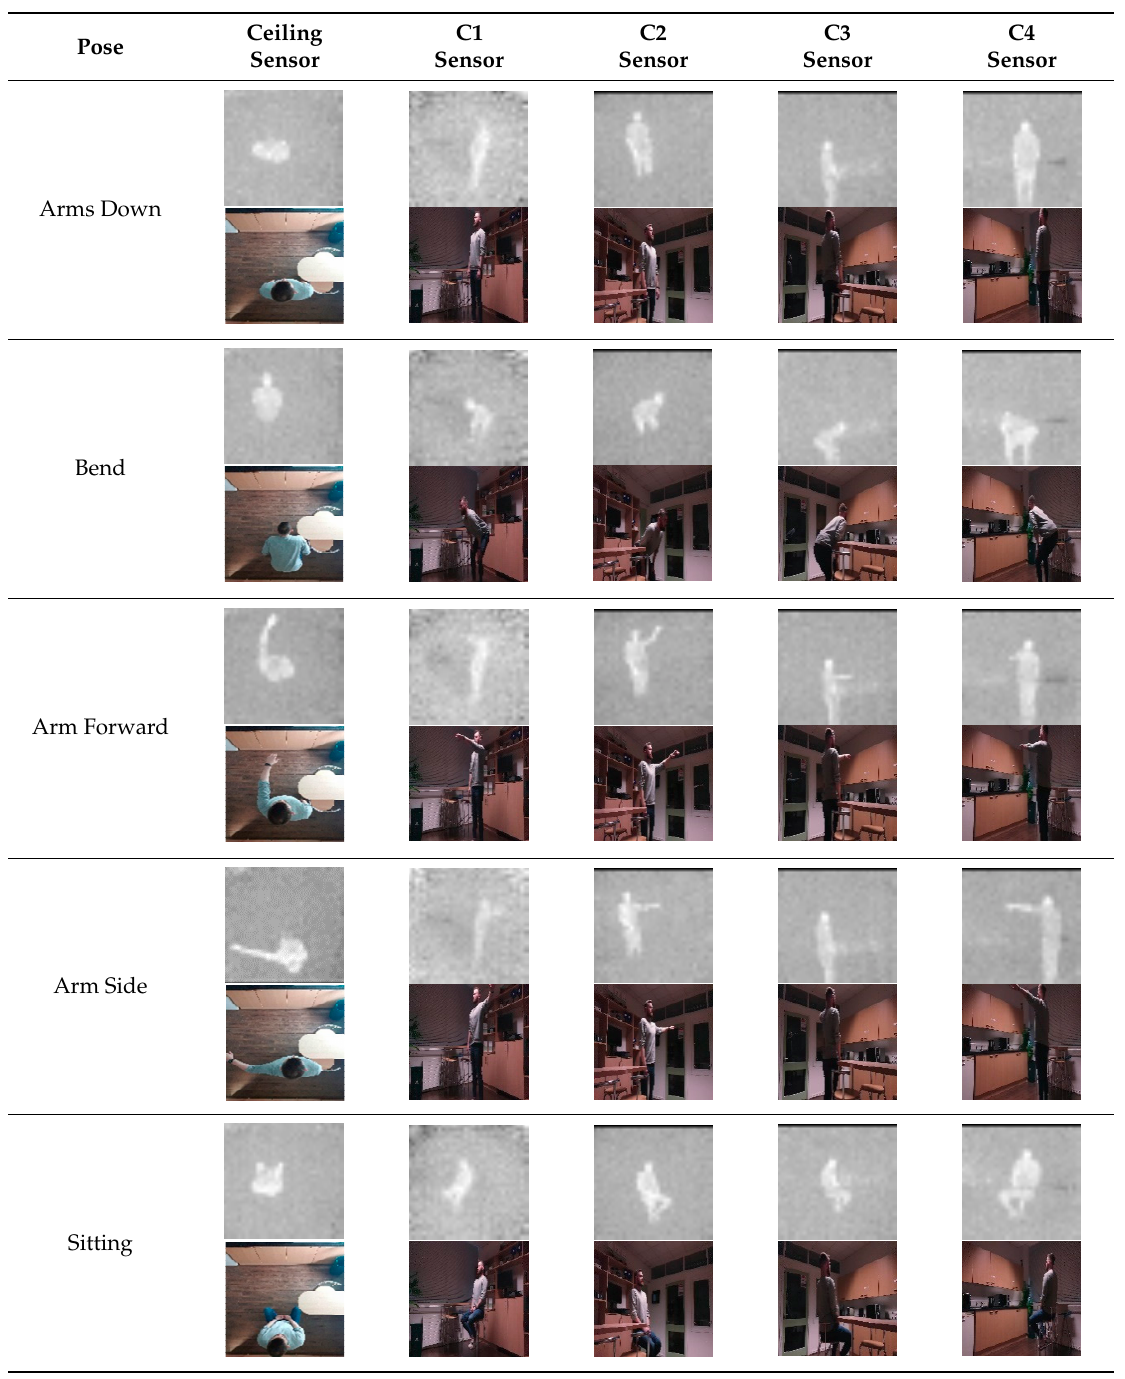
Table 1. Examples of the five classes as seen from each thermopile infrared sensor (TIS) viewing angle.